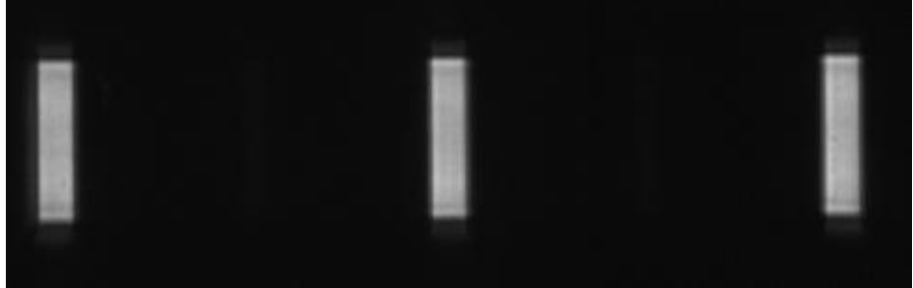
Figure 5. Magnified images of the output from the microslicer when illuminated with a whitelight continuum source. These virtual slitlets are used as inputs to the spectrograph, as shown in Figure 1. A cross-section through one of these slices is shown in Figure 6.